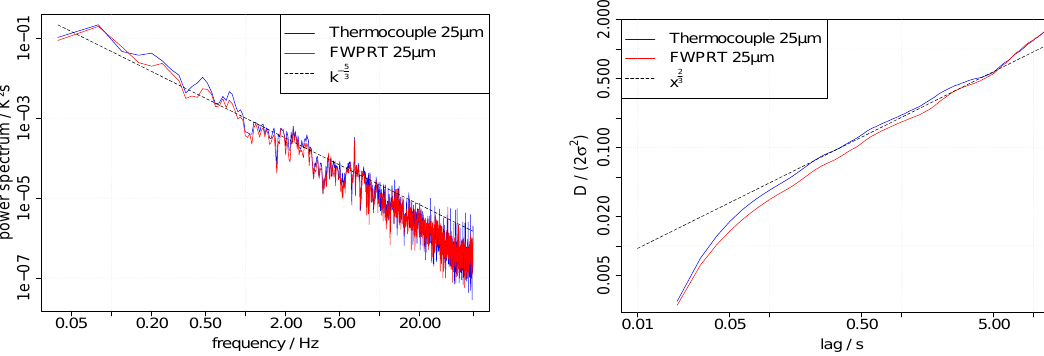
Fig. 17. Variance spectra (left panel) and structure function (right panel) of both sensors, compared to Kolmogorov laws of turbulence: the spectra that are shown are averaged over four single spectra of 25s time series each. The structure function is normalized by 2 σ 2